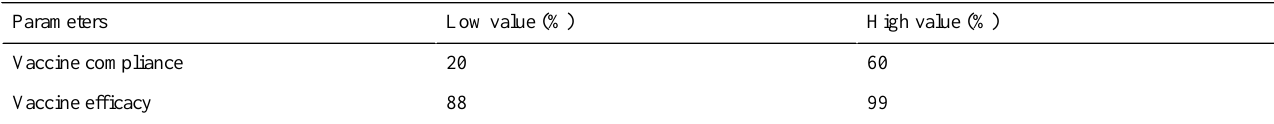
Table 3. Vaccine parameters used in the study. Intermediate values in the interval bounded by the low and high values are automatically